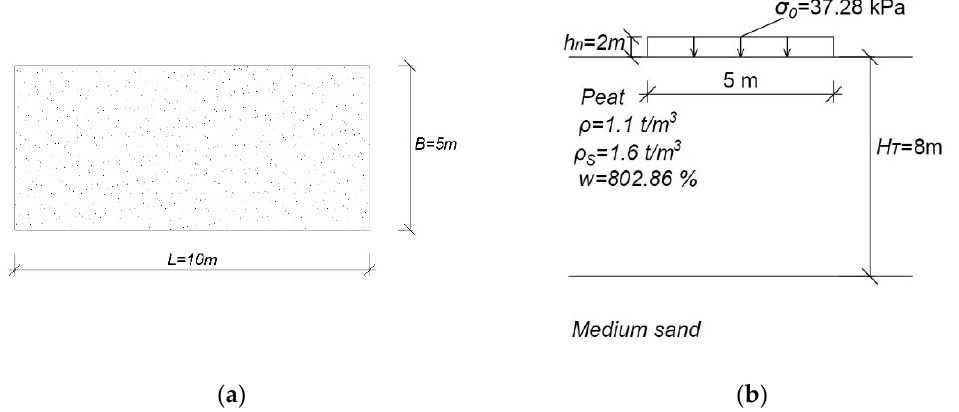
Figure 9. Conditions adopted for the analyses: ( a ) dimensions of the embankment; ( b ) cross-section. The embankment was divided into smaller calculation areas. Points and forces acting inside each field were determined with the use of a proprietary calculation program. The division of the embankment is shown in Figure 10.